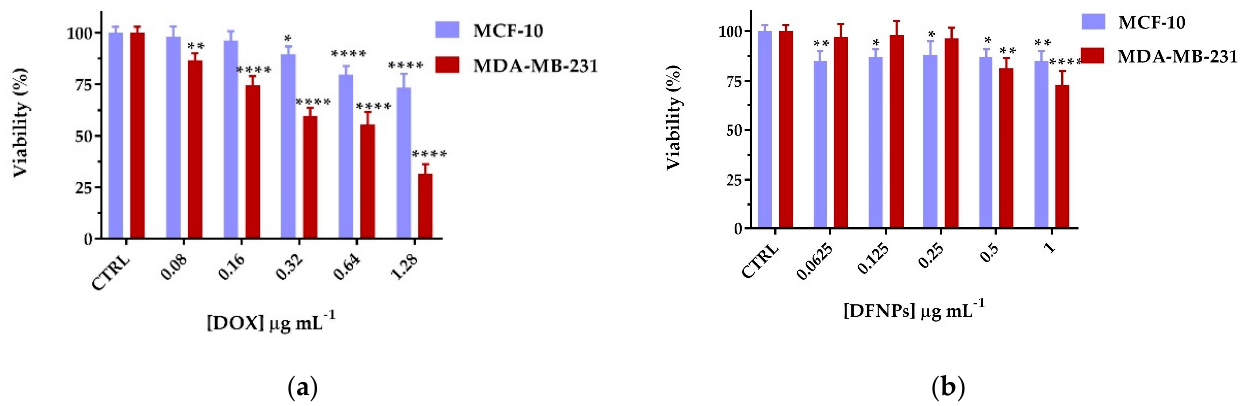
Figure 8. Viability percentages of ( a ) free DOX and ( b ) DFNPs on MCF-10A and MDA-MB-231 cell lines after 72 h. * p < 0.05, ** p < 0.01, *** p < 0.001, and **** p < 0.0001 vs. each control (two-way ANOVA followed by Tukey’s post-test; data are expressed as mean ± SD of three independent experiments).